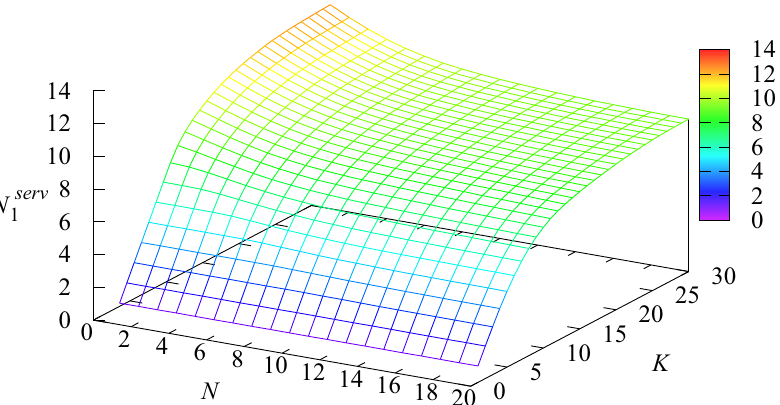
Figure 2. Dependence of the average number N serv and K